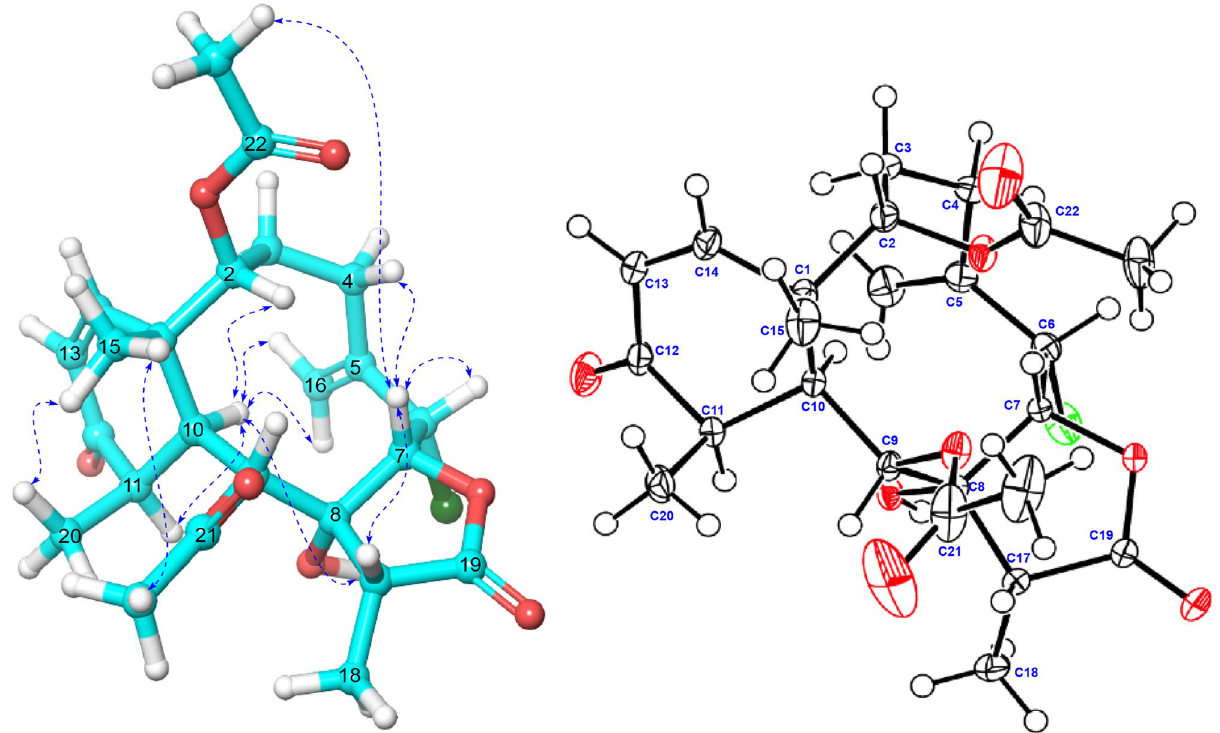
Figure 5. ( a ) Key NOESY correlations observed in compound 1 . ( b ) ORTEP X-Ray representation of compound 1